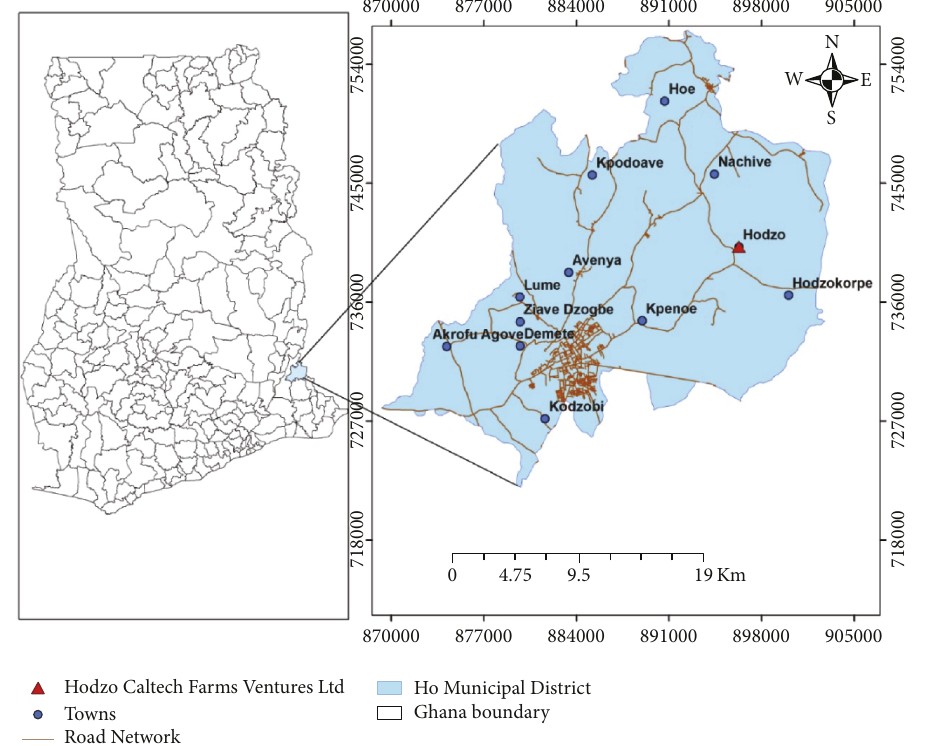
Figure 1: Map of Volta regional location showing study site (source: Ghana Statistical Service, GIS (2010 Population and Housing Census District Analytical Report, Ho Municipality, 2014)).